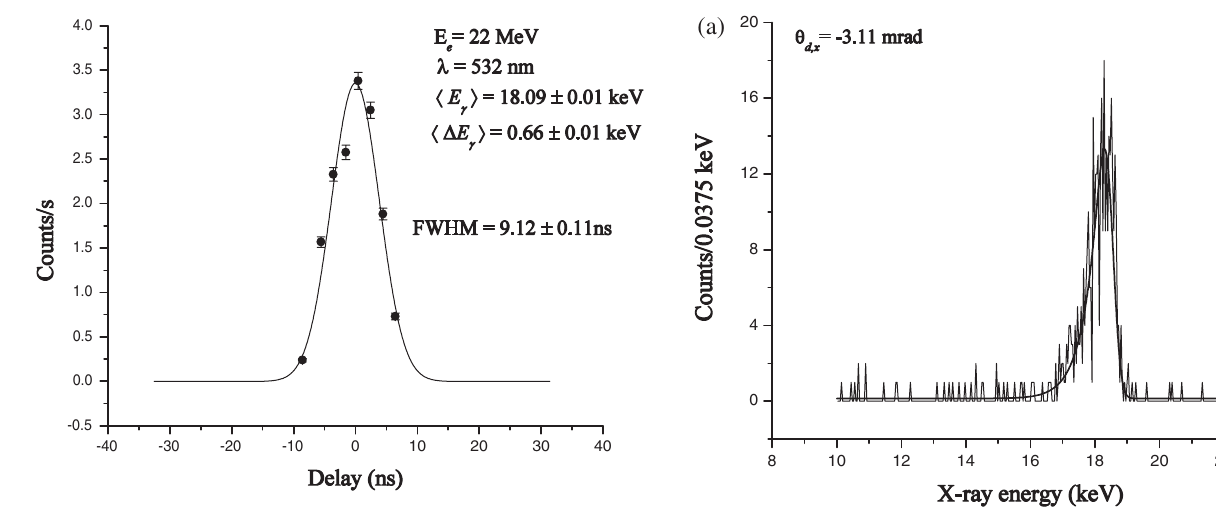
FIG. 10. X-ray intensity as a function of the delay between the laser and electron beam. Each point corresponds to the integrated x-ray yield per